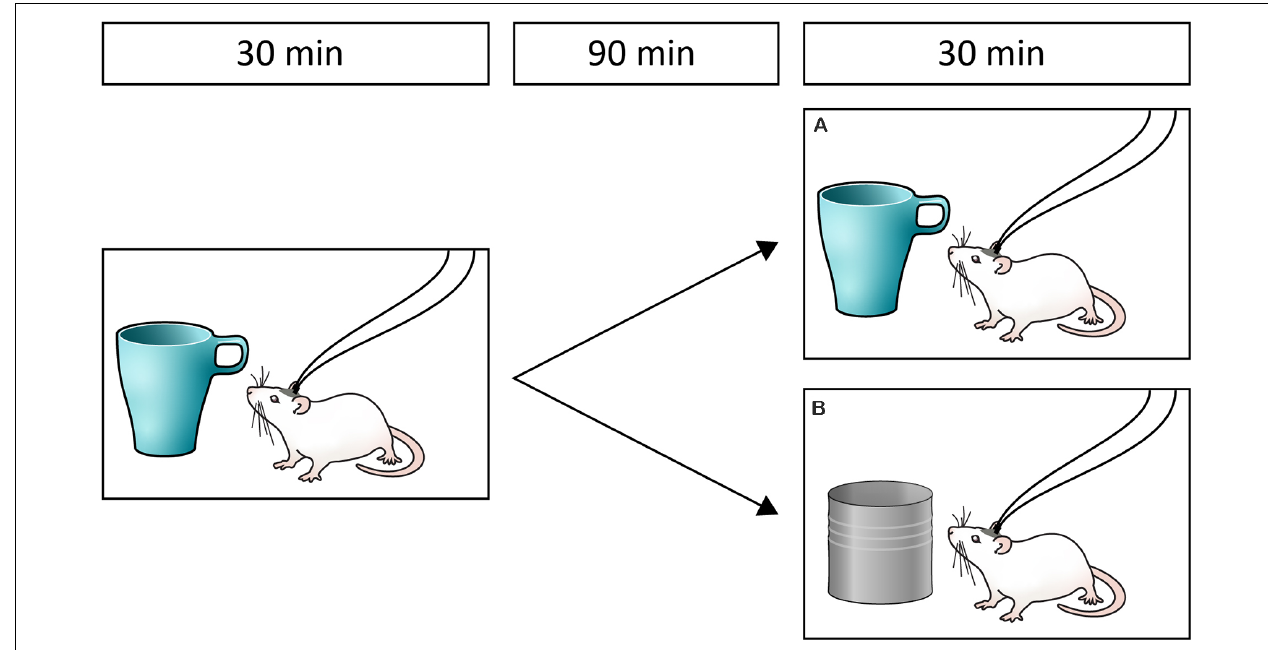
FIGURE 1 | Experimental design. After steady baselines of dopamine and norepinephrine output were obtained, rats were presented with an object for 30 min and after a 90 min retention period, presented with either a familiar (A) or a novel object (B) .